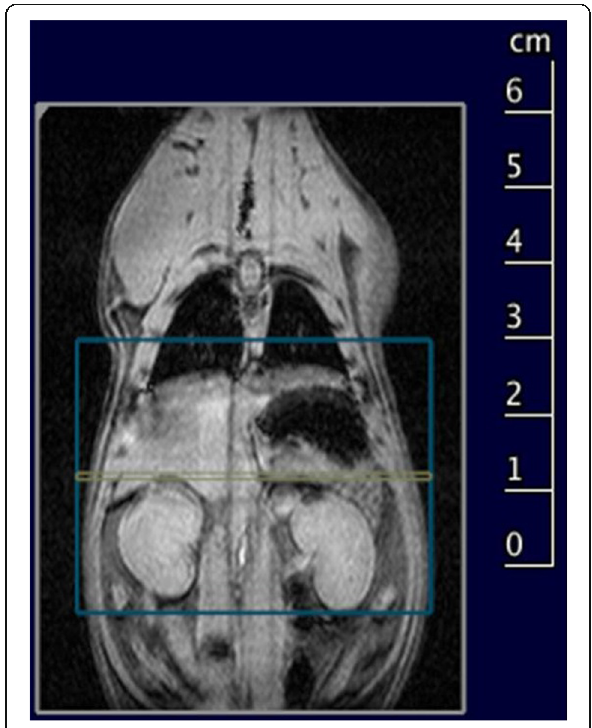
Fig. 1 Slice geometry of the 1 H T2-weighted rapid acquisition with refocused echo (RARE) sequence visualised onto a multiplane multislice localiser sequence of a non-injected